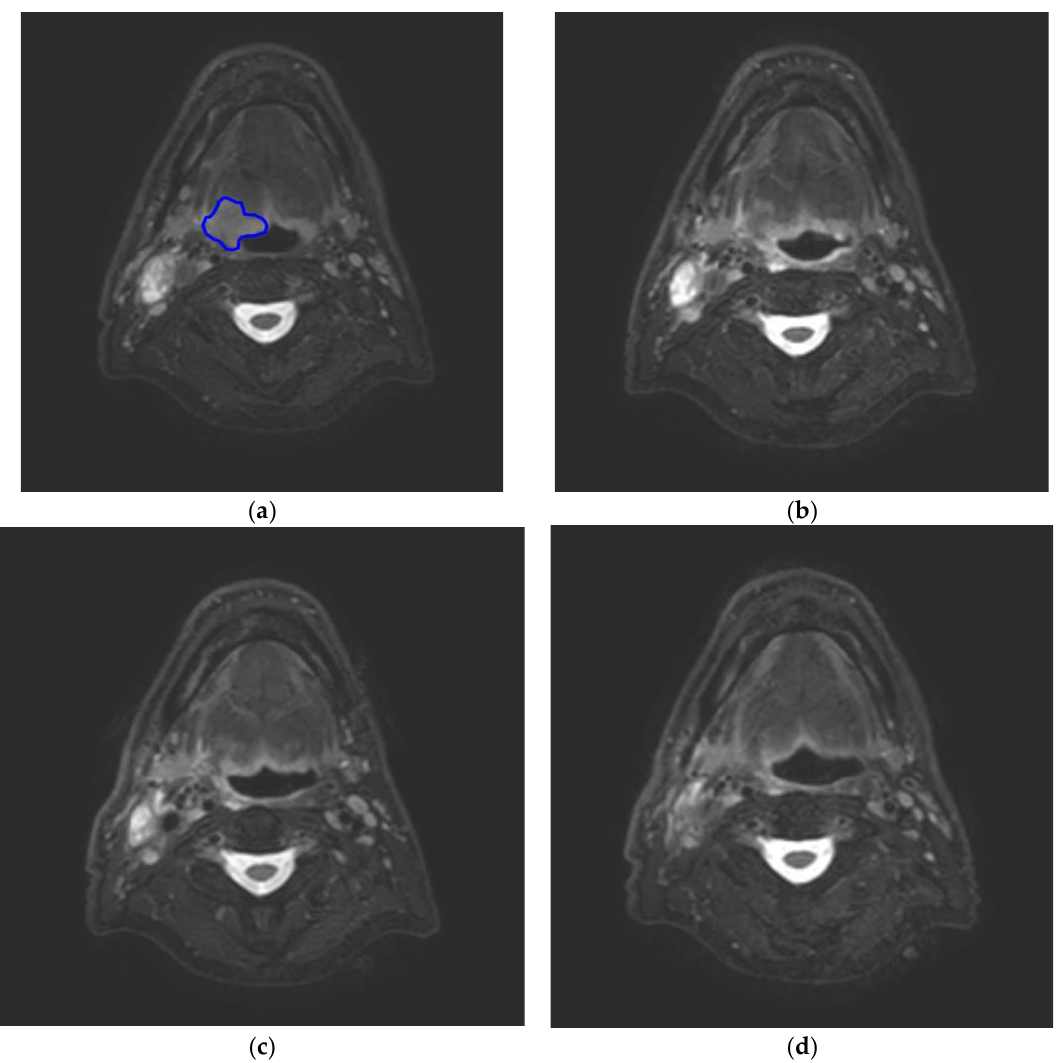
Figure 2. Four consecutive T2 TSE mDIXON images of a patient with a T2N1 HPV+ oropharyngeal carcinoma originating in the base of tongue on the right side (blue) treated with radiotherapy showing the shrinkage of the tumor. Week 1 ( a ), week 2 ( b ), week 3 ( c ) and week 4 ( d ).